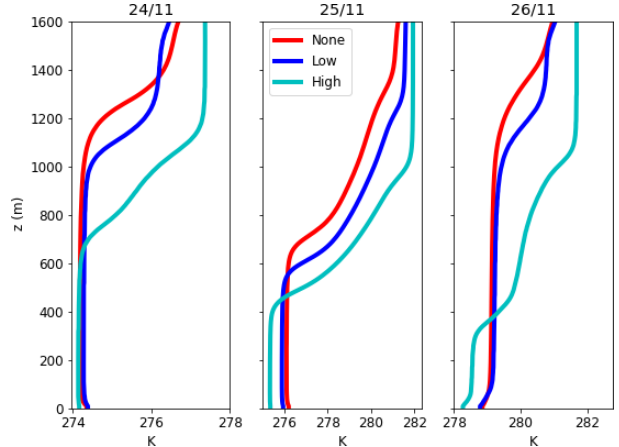
Figure 5. Potential temperature profiles at 17:00LST for 24, 25 and 26 November, with no aerosols (red), low aerosol loading (blue) and high aerosol loading (turquoise).